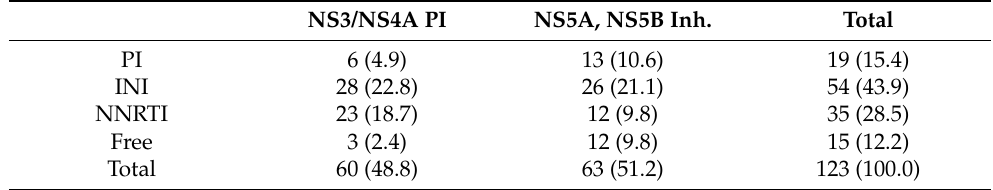
Table 2. Contingency table with frequencies n (%) of ART and DAA use *. χ 2 : 11.4438, p =